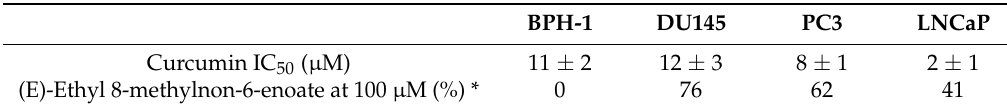
Table 2. IC 50 for curcumin and ( E )-ethyl